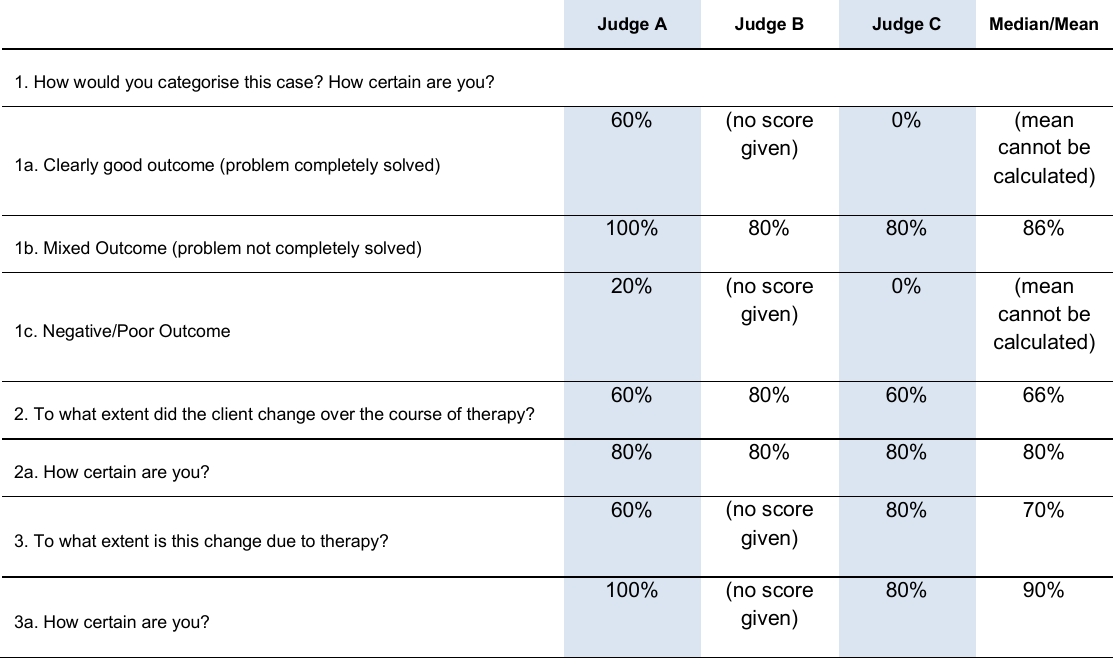
Table 3: Adjudication